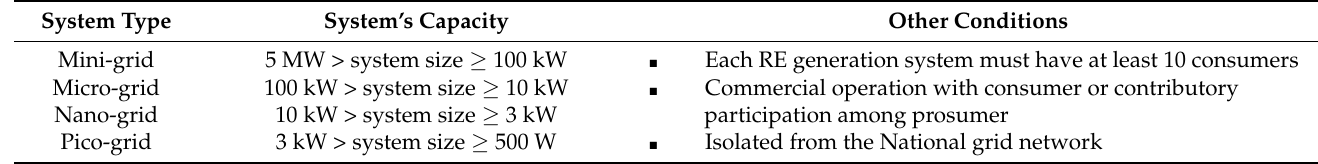
Table 7. Definition of RE-based mini-grids, micro-grids, nano-grids, and pico-grids [82].